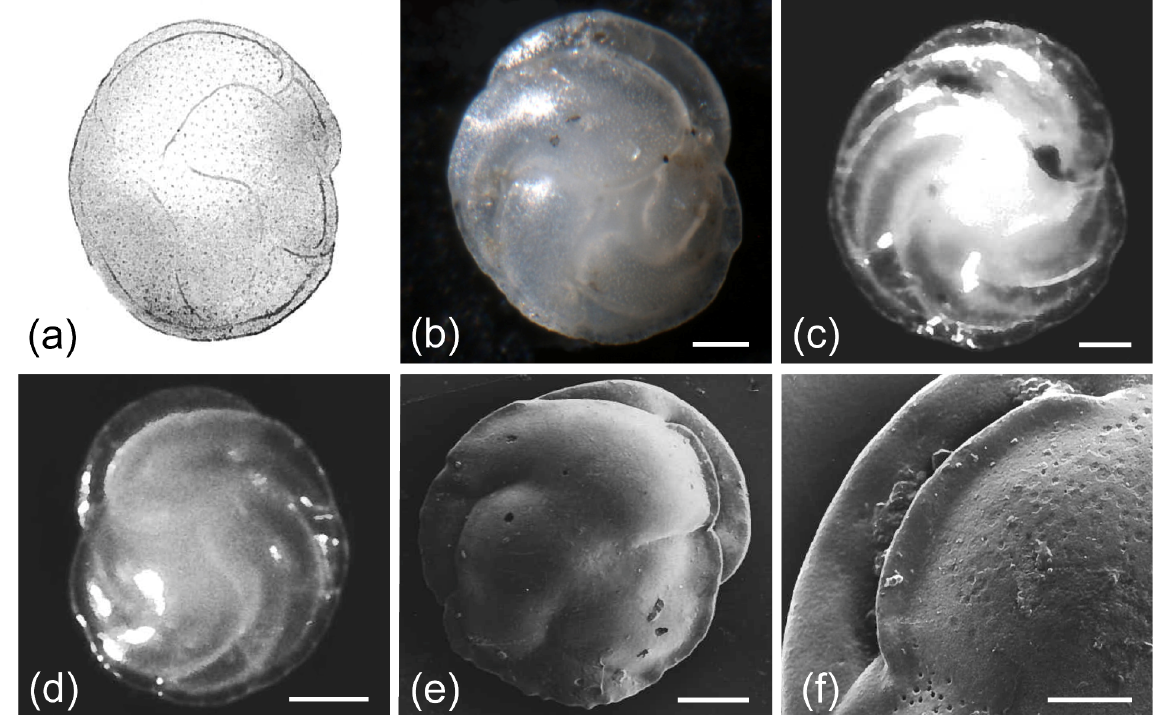
Figure 3. Paracassidulina neocarinata . (a) Original holotype illustration and (b) an image of a syntype. Note that no information about size or size ranges is provided in the original description by Cushman (1922). (c–d) Light microscope images of P. neocarinata . (e–f) SEM micrographs of (e) the species, including (f) a detailed view of the aperture. All scale bars denote 50µm, except for (f) where it denotes 25µm. Sample details are given in Supplement Table S1. The original holotype illustration (a) is reproduced by permission from the Smithsonian Libraries; the syntype image (b) is from the Paleobiology Collections of the Smithsonian National Museum of Natural History (https: //collections.nmnh.si.edu/search/paleo/, last access: 19 October 2020) and made available under the Creative Commons CC0 1.0 licence. (c–f) Reproduced from Seidenkrantz (1995), by permission from the Journal of Micropalaeontology